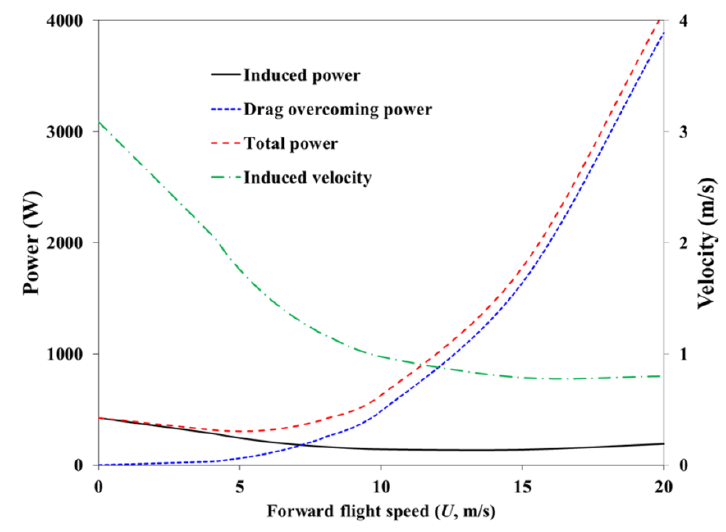
Figure 7. Required rotor power, induced power and drag overcoming power with various flight speed.